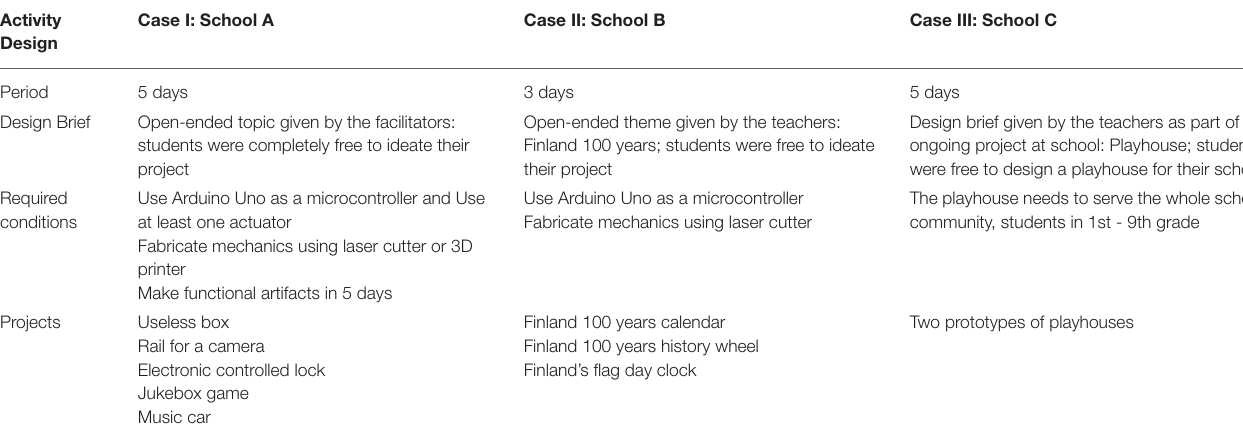
TABLE 2 | The three schools participating in digital fabrication